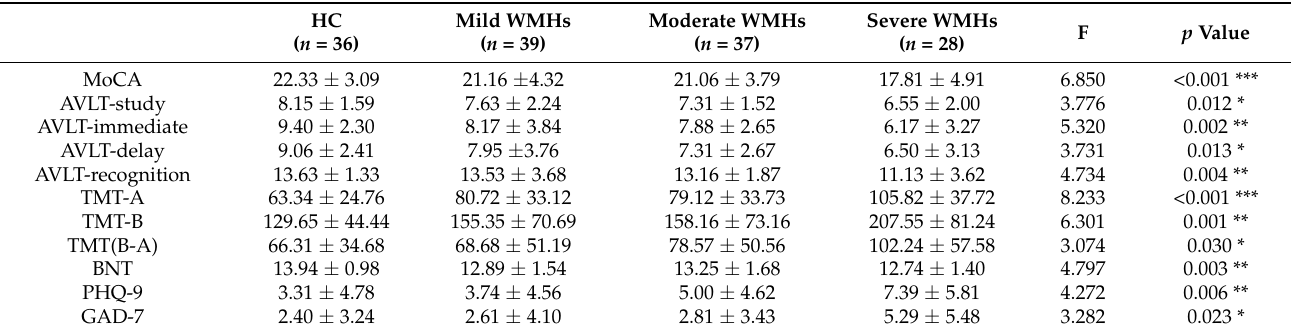
Table 2. Neuropsychological